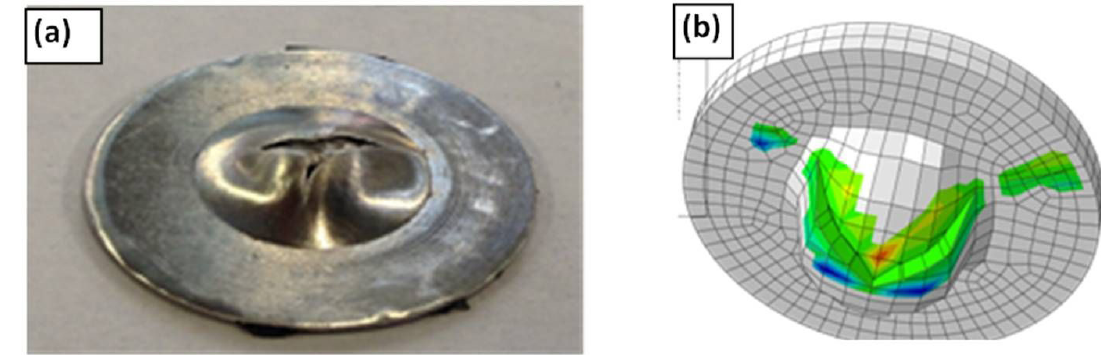
Figure 17. Al sheets after fracture in SPT, (a) experimental and (b) numerical.